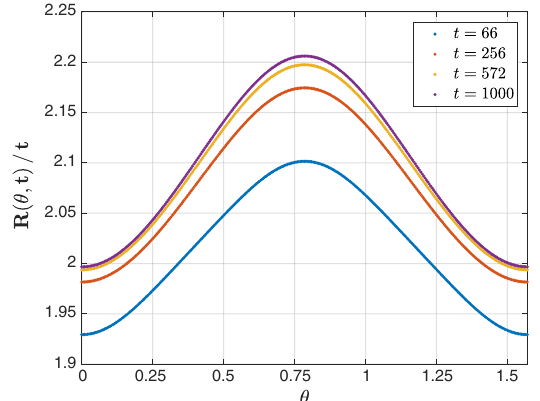
FIG. 11. Anisotropy in the cluster profile: Numerically de- termined anisotropy in the average shape of the 2D cluster R ð θ ; t Þ =t , at the indicated times. The anisotropy in the cluster shape grows in time and appears to asymptote to a nontrivial steady-state shape.